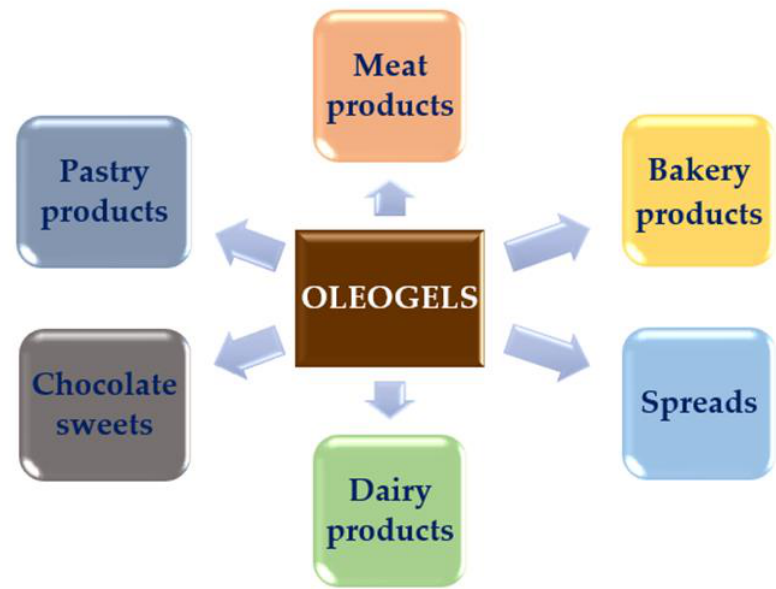
Figure 1. Research fields for applicability of oleogels in foods.